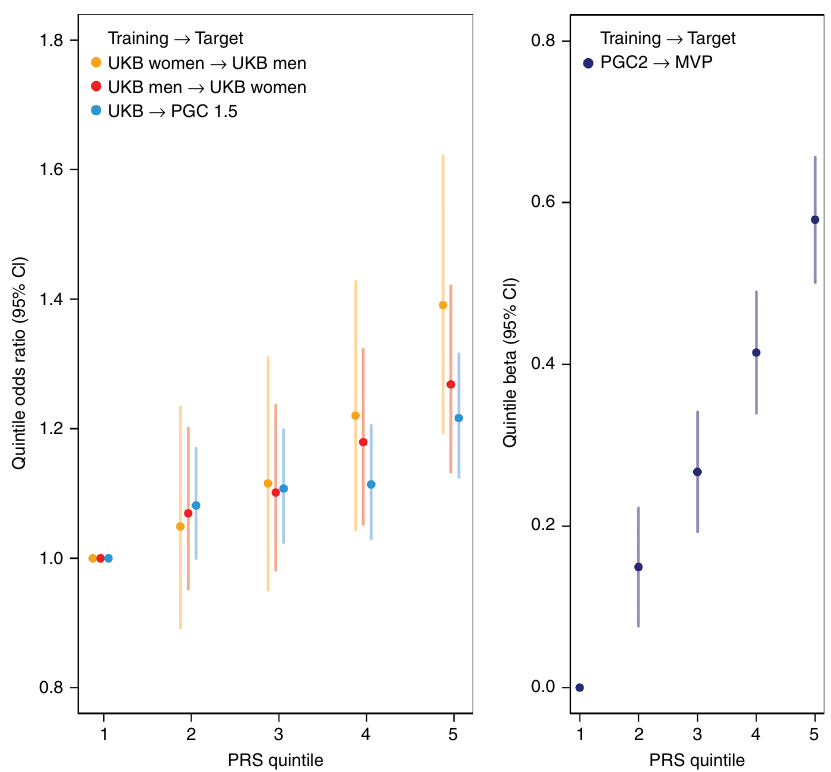
Fig. 2 Genetic risk score (PRS) predictions for PTSD. a Using PTSD subjects from the UK Biobank (UKB) as discovery sample, odds ratios (OR) for PTSD per PRS quintile relative to the fi rst quintile show a signi fi cant increase in different PGC PTSD target samples. For example, UKB men in the 5th quintile have 40% higher odds to develop PTSD than UKB men in the lowest quintile, when using women from the same population as a training set. b PRS predictions of re-experiencing symptoms in the external replication cohort from the Million Veteran Program (MVP) using the overall PGC2 as discovery sample show a highly signi fi cant increase in PTSD re-experiencing symptoms per PRS quintile. Sample sizes in different training and target sets include: UKB women: 6845 PTSD, 64,099 controls; UKB men: 3,544 PTSD, 51,700 controls; UKB: 10,389 PTSD, 115,799 controls; PGC1.5: 10,213 PTSD,